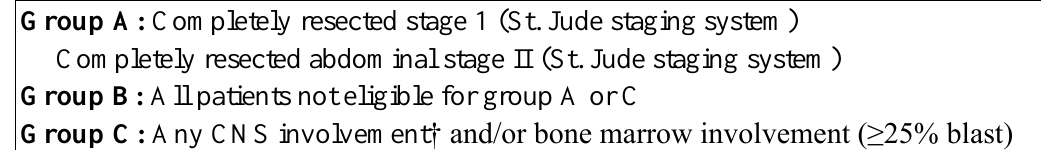
Table 1. FAB* Staging System for B-Cell